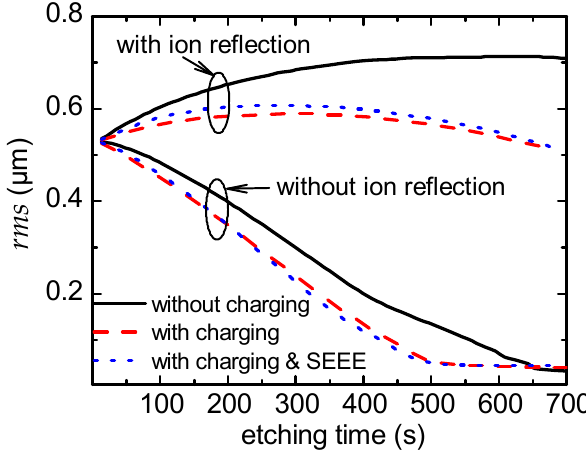
Figure 7. The rms roughness vs. the etching time for the surface profiles shown in Figures 5 and 6.